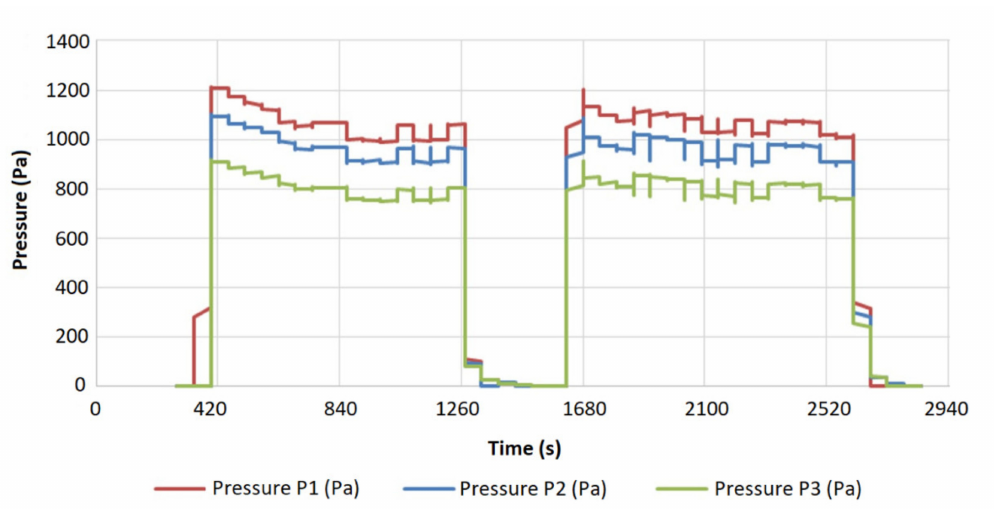
Figure 14. Pressure waveform recorded during underground